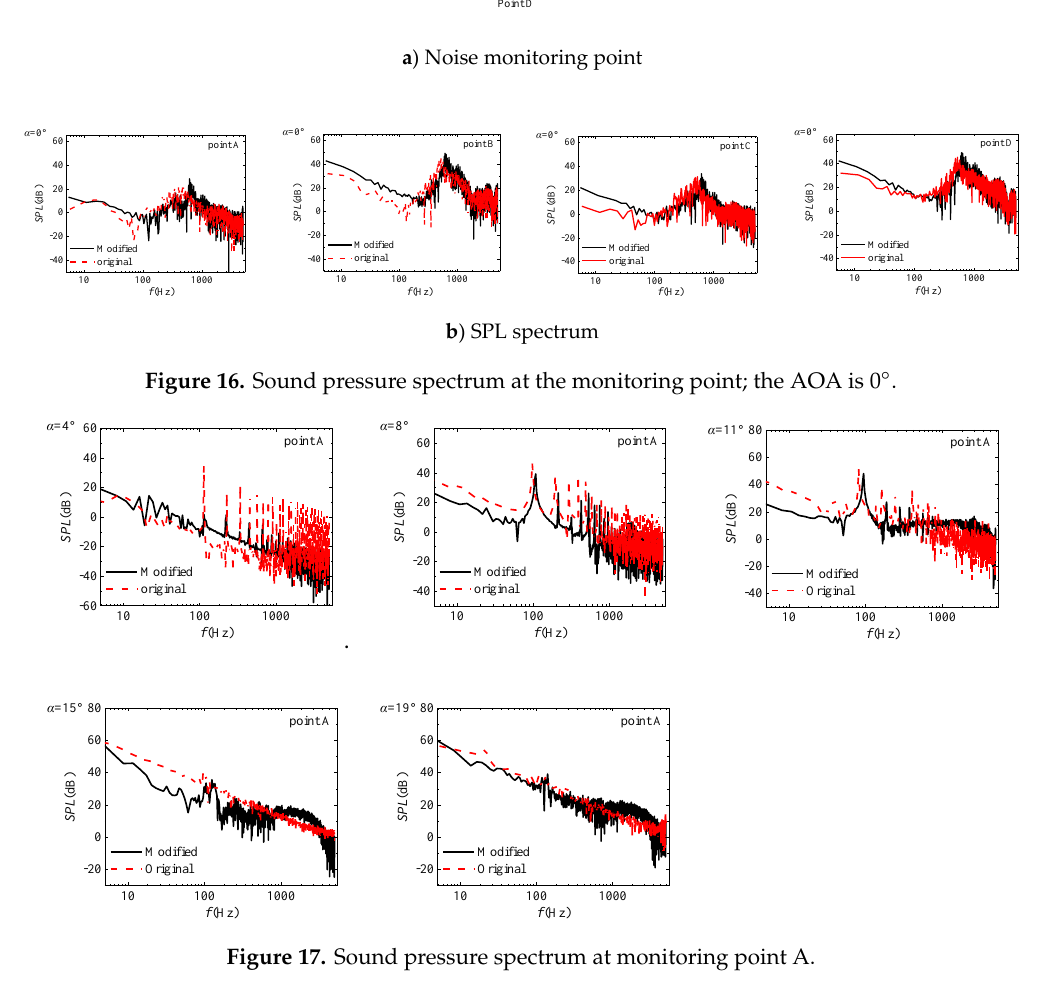
Figure 17. Sound pressure spectrum at monitoring point A.